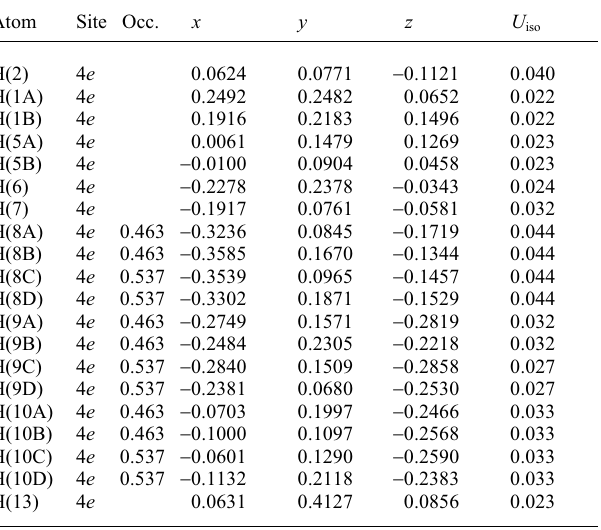
Table 2. Atomic coordinates and displacement parameters (in Å 2 ) .